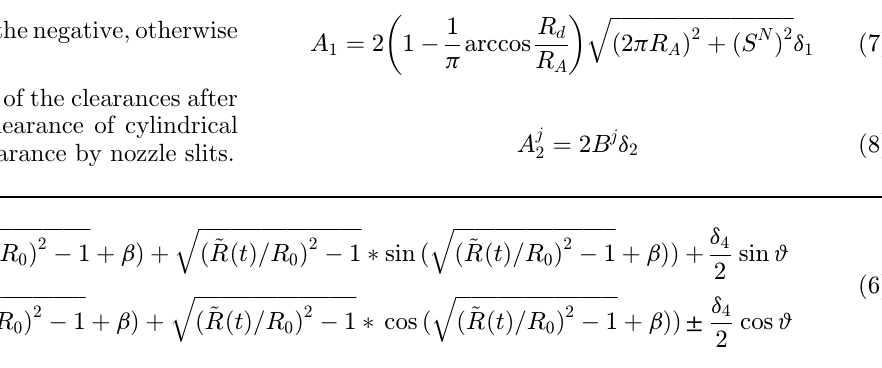
Fig. 6. Four types of clearances: (a) circumferential clearance; (b) radial clearance; (c) tooth side clearance; (d) the tooth shape clearance.